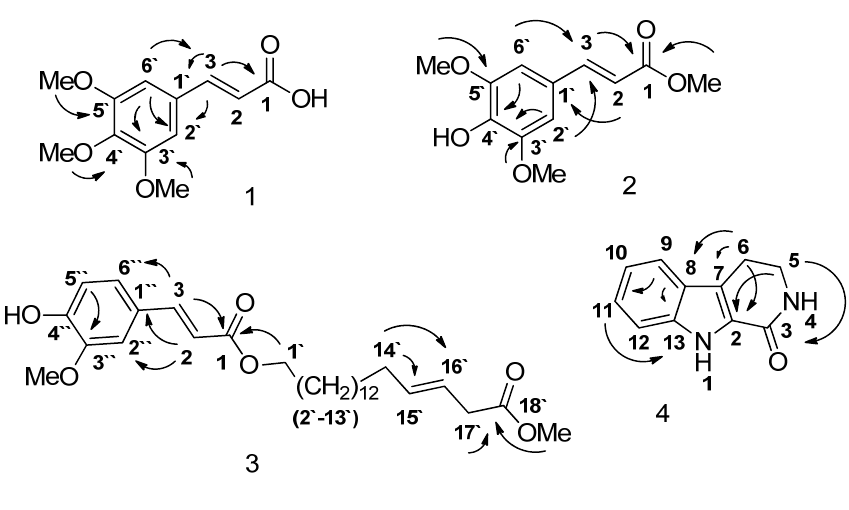
Figure 2. HMBC correlations of compounds 1 to 4